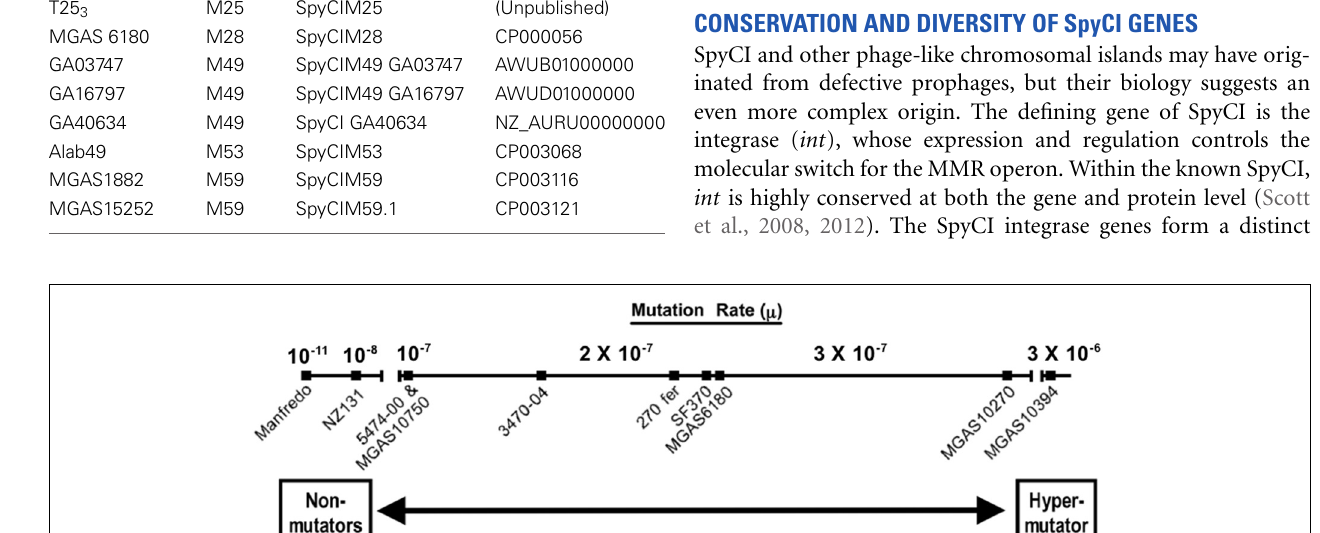
operon. The mutation rate is calculated as mutations per generation. The figure was drawn using the data from Scott et al. (2012).